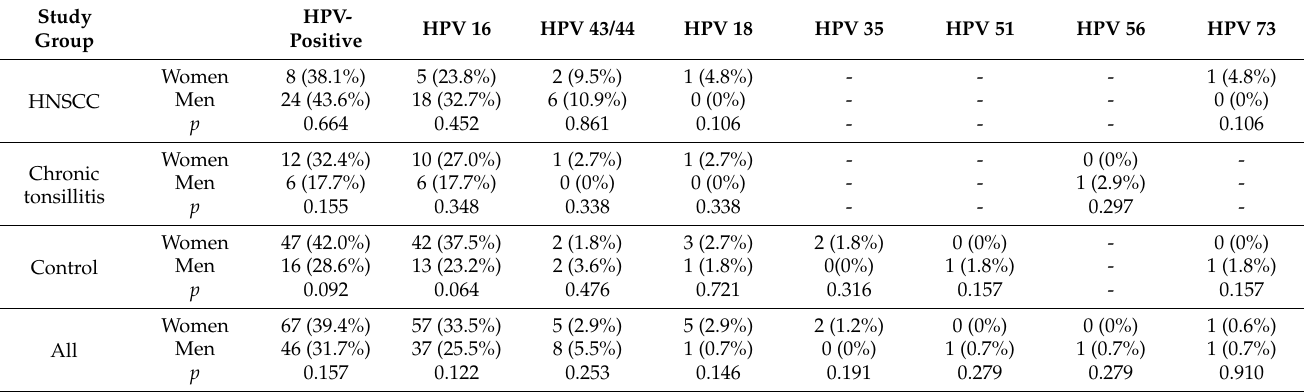
Table 6. The number of HPV-positive results depending on sex in individual study groups, considering the HPV vari- ant. The percentages of HPV-positive results are given in parentheses. Statistical significance ( p ) was calculated using the proportion